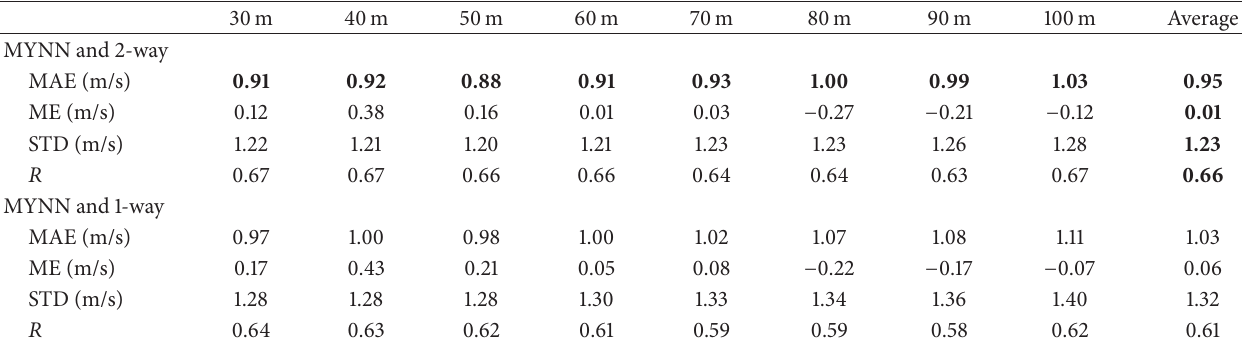
Table 8: Statistical metrics (MAE in m/s, ME in m/s, STD of the ME in m/s, and 𝑅 ) for the wind speed at 8 vertical levels (30–100m), so as to evaluate the performance of one- and two-way nesting options at the 3 km WRF modelling